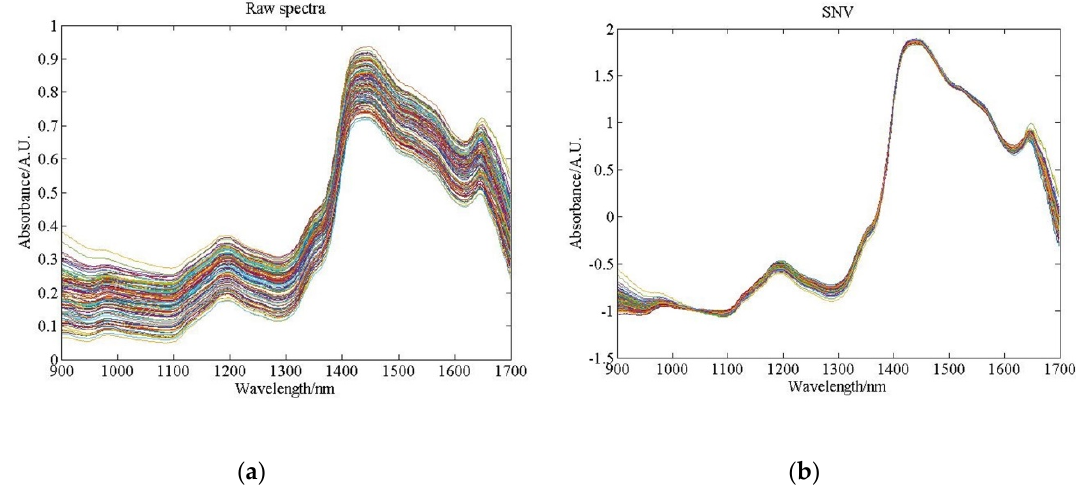
Figure 3. Near-infrared (NIR) raw spectra and standard normalized variable (SNV) pretreated spectra of whole pine nuts, ( a ) The raw spectra, ( b ) The SNV pretreated spectra. Raw spectral data were collected from ground samples for regression analysis. After SNV processing, the data were compressed by the wavelet noise reduction threshold. Figure 4 shows the inverse transformation results after compression of the raw spectra, the SNV pretreated spectra, and the ‘db9’, ‘bior4.4’, ‘sym8’, and ‘coif4’ noise reduction thresholds. High-frequency noise was filtered out by reconstructing NIR spectral bands in ‘db9’. Compared with the original NIR spectroscopy, the spectra of ‘bior4.4’ and ‘sym8’ in the wavelength ranges of 1100–1200 nm and 1600–1700 nm subintervals were